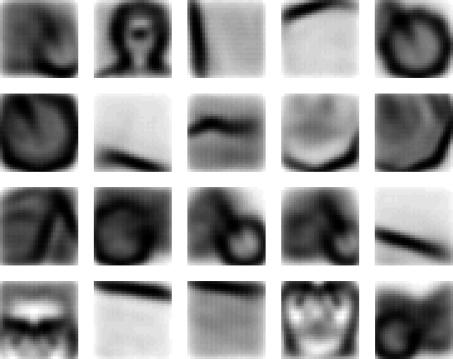
Hebbian Learning: Final Reconstructions for the 20 Features in the Mixed CaseAs with STDP-based learning, the 20 cells self-organized, some having developed selectivity to face features, and some to motorbike features.